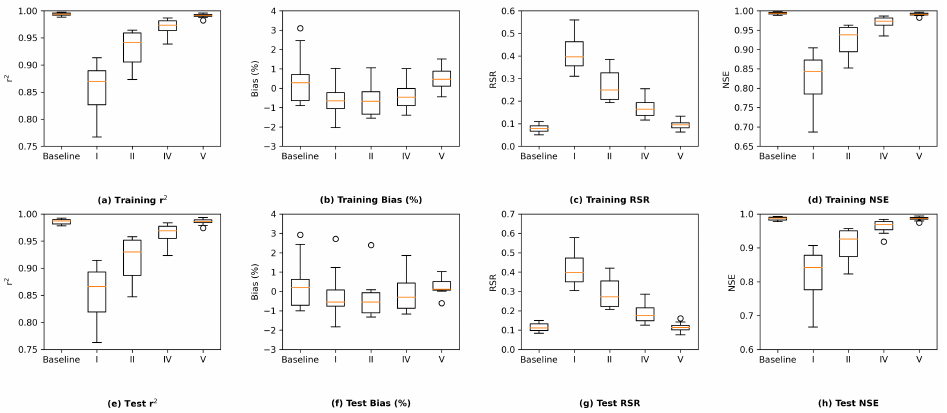
Figure A11. Box and whisker plots of four types of metrics consisting of r 2 , percent bias, RSR, and NSE on stations belonging to the western Delta group during the training (panels ( a – d )) and test (panels ( e – h )) phases of the grouped (G) LSTM model under five scenarios: baseline and four different memory lengths as presented in Table